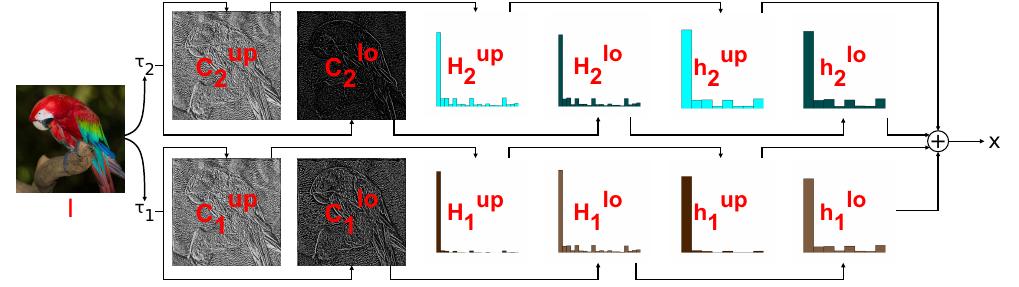
Figure 16. Illustration of process of extracting the feature vector x with L = 2.